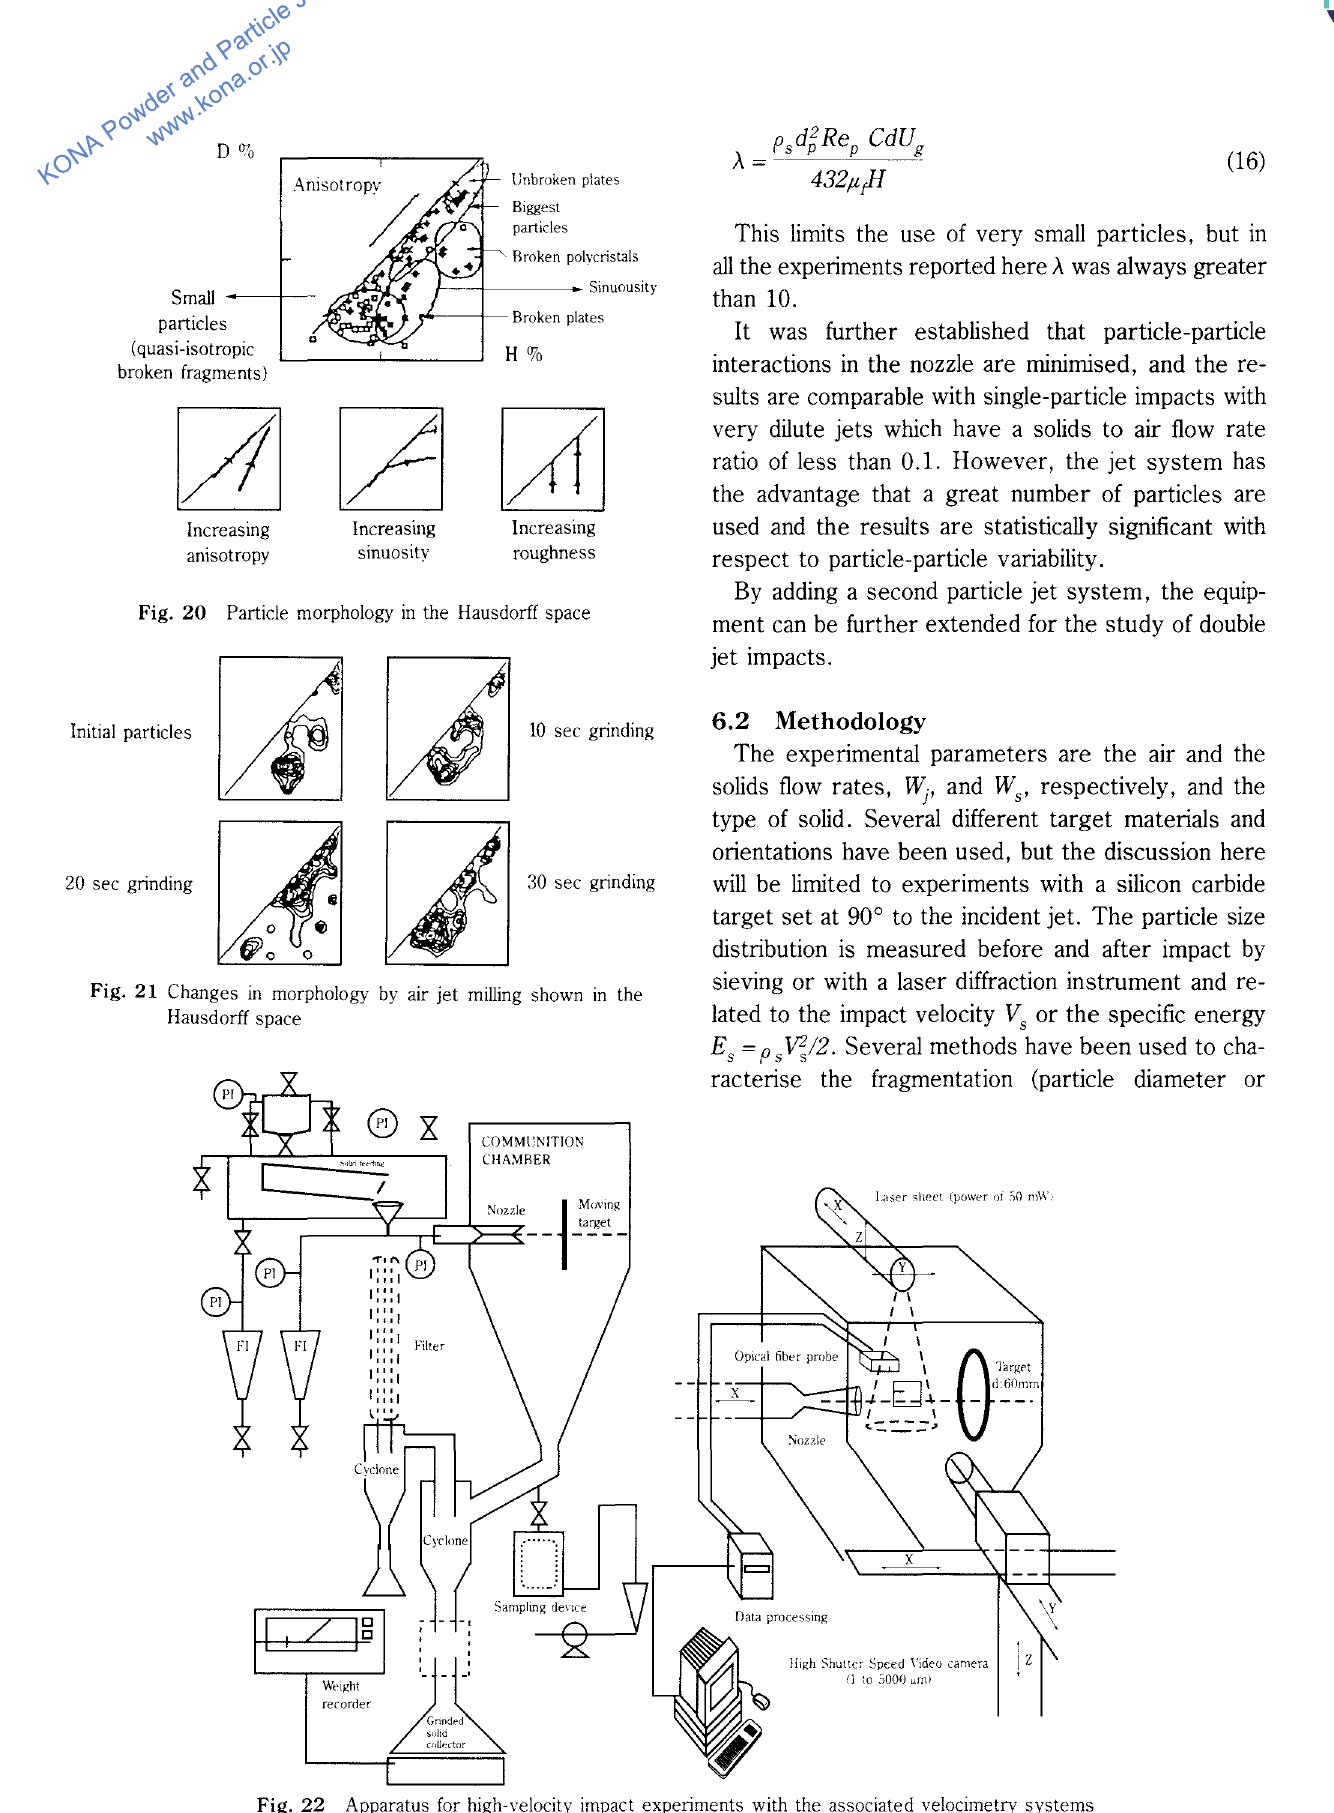
Fig. 22 Apparatus for high-velocity impact experiments with the associated velocimetry systems